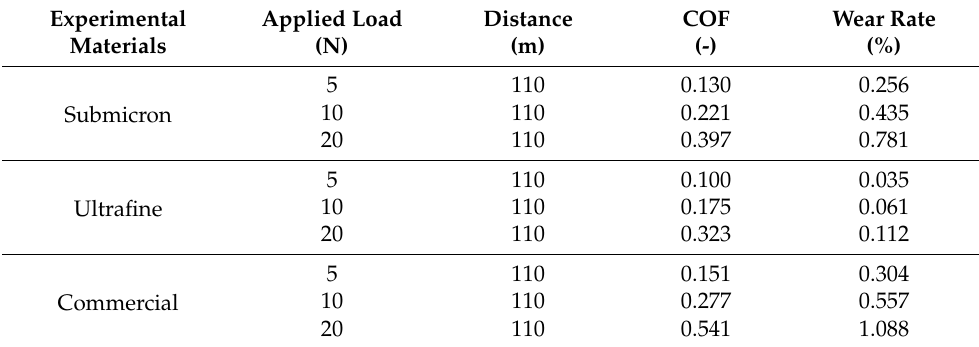
Table 3. Tribological and wear properties of investigated